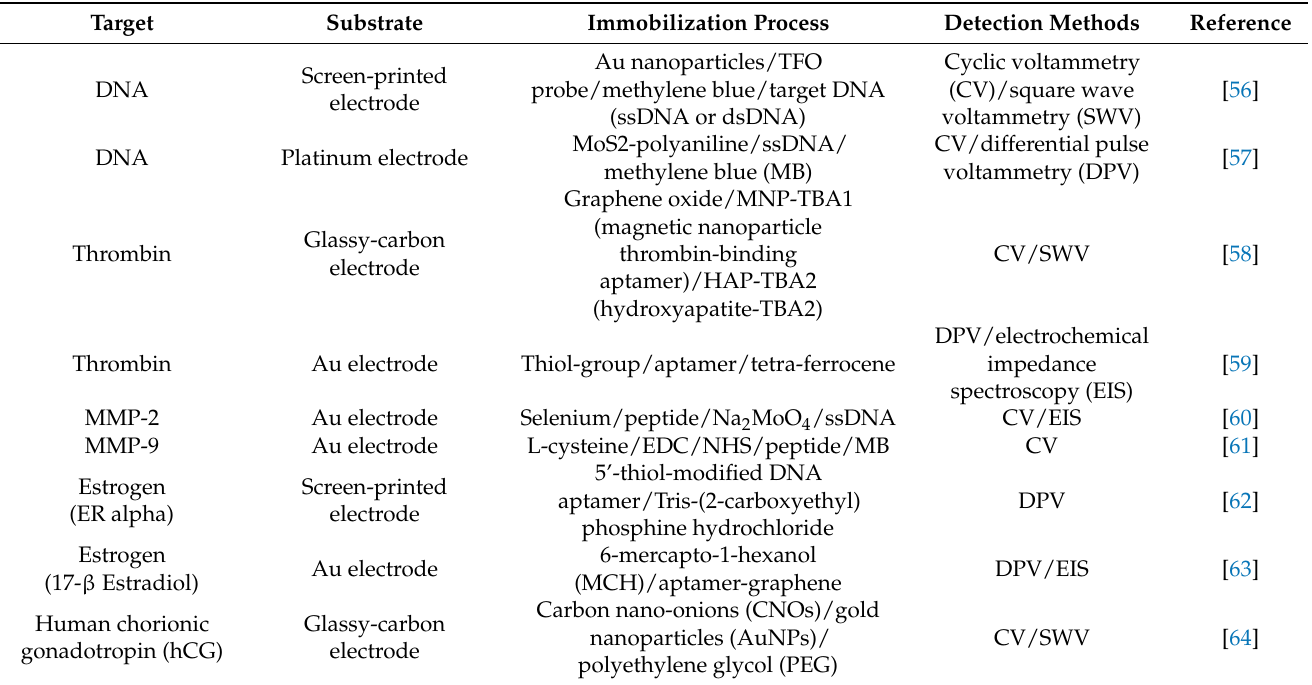
Table 3. Electronic biosensor systems for the detection of